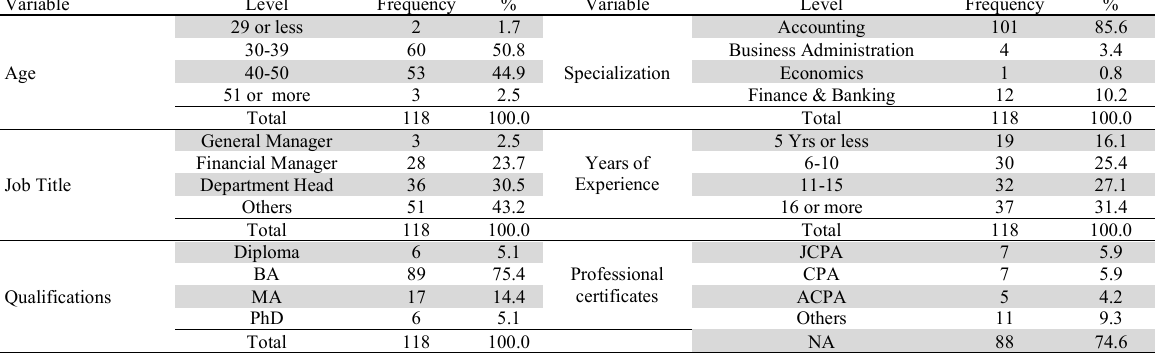
Distribution of study sample members according to the personal variables